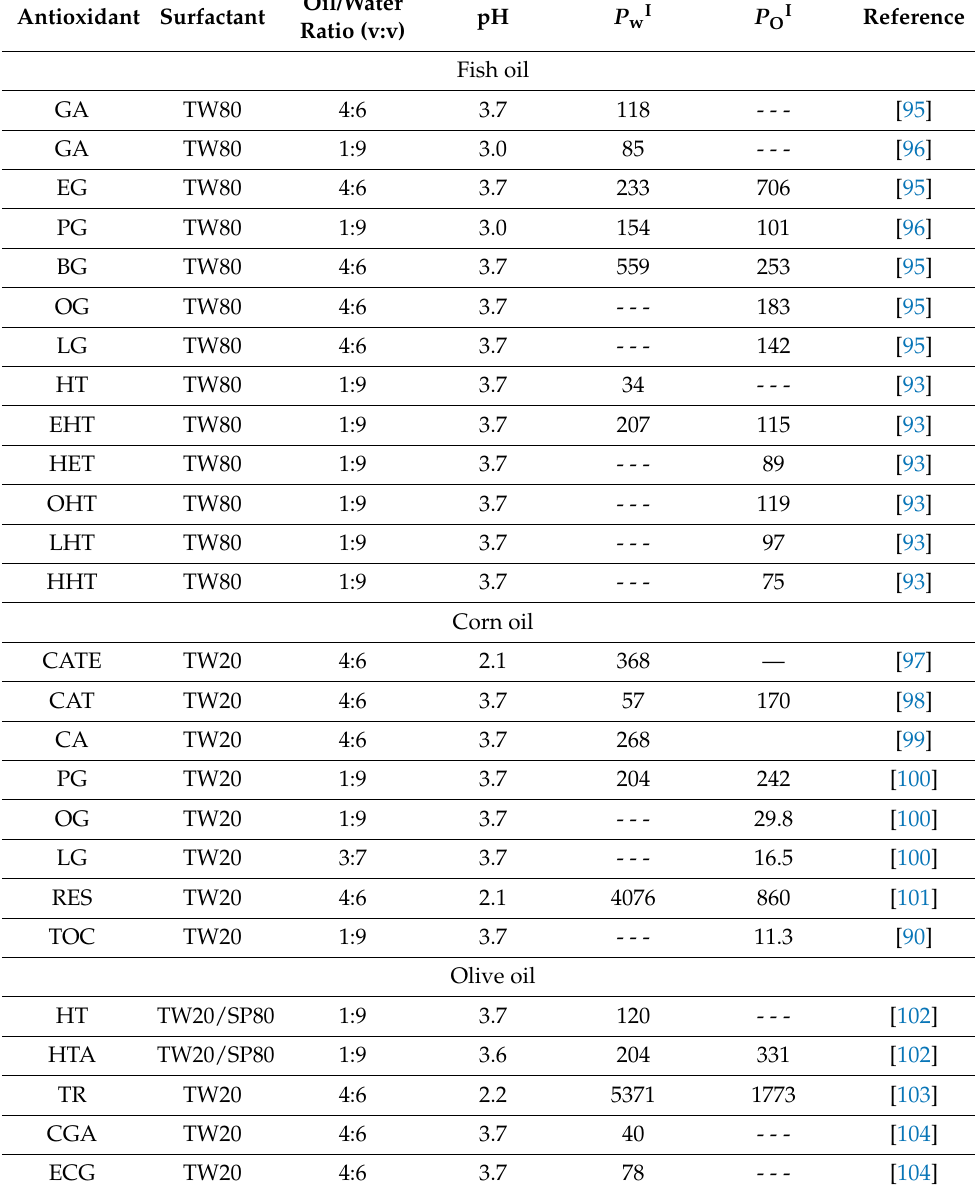
Table 7. Values of the partition constants of antioxidants (AO) between the aqueous-interfacial ( P wI ) and oil-interfacial ( P OI ) regions of emulsions. Partition constant values are determined in the intact emulsions by employing a kinetic methodology [42,45] to avoid disruption of the existing equilibria to avoid biasing of values. TW20 = Tween 20, TW80 = Tween 80, SP80 = Span 80. BG: butyl gallate;